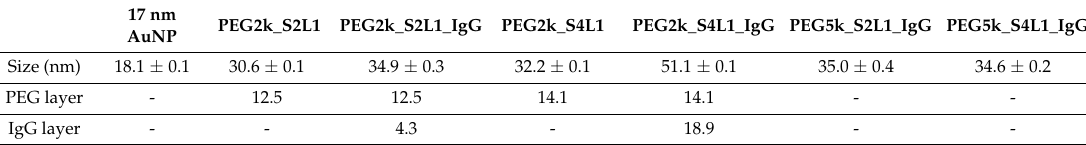
Table 1. Hydrodynamic diameters of as synthesized AuNPs (17 nm), and PEGylated and anti-mouse IgG bioconjugated AuNPs by dynamic light scattering.